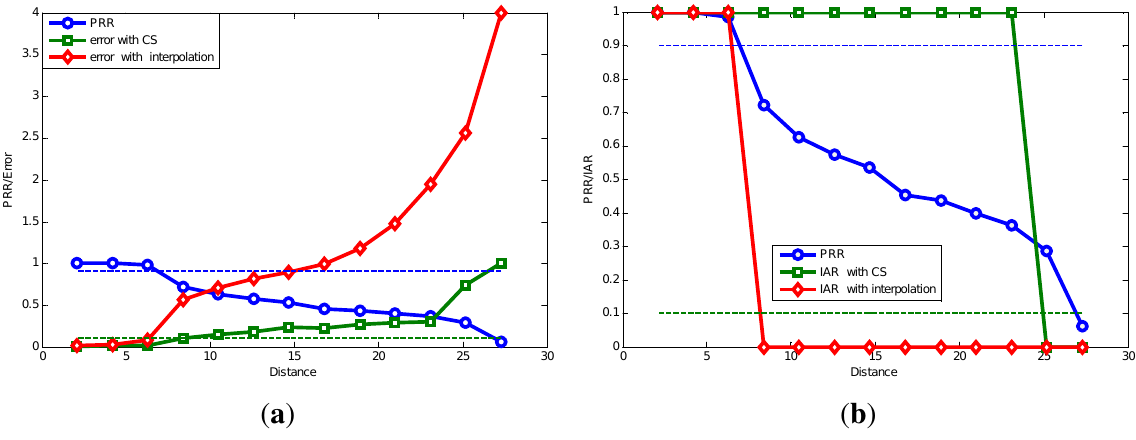
Figure 22. Sparse signal transmission performance. ( a ) Packet reception rate (PRR) and recovery error comparison with varying transmitting distance; ( b ) PRR and information acquisition rate (IAR) comparison with varying transmitting distance.